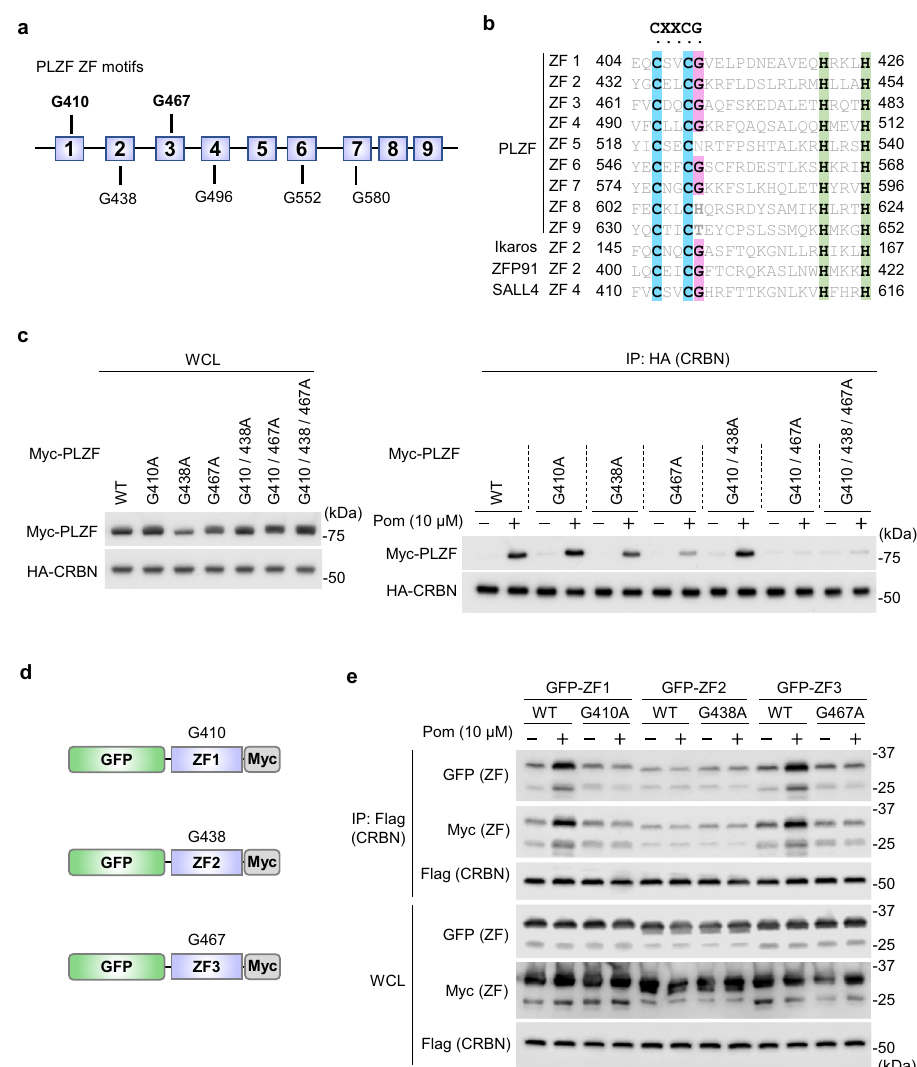
Fig. 3 G410 and G467 of PLZF are critical for its binding to CRBN in the presence of pomalidomide. a Schematic representation of the ZF motifs of PLZF. b Multiple sequence alignment showing PLZF ZF motifs along with validated ZF degrons from Ikaros, ZFP91, and SALL4. Cys and His residues (blue and green, respectively) comprising ZF motifs and critical Gly residues (red) are highlighted. c FLAG-HA (FH)-CRBN and Myc-FLAG (MF)-PLZF carrying point mutations were coexpressed in 293T cells and immunoprecipitated with anti-HA antibody in the presence or absence of pomalidomide. d Schematic representation of EGFP-fused PLZF ZF proteins. e FH-CRBN and EGFP-fused PLZF ZF proteins were coexpressed in 293T cells and immunoprecipitated with anti-Flag antibody in the presence or absence of pomalidomide. WCL whole-cell lysate. All experiments were conducted more than twice with similar